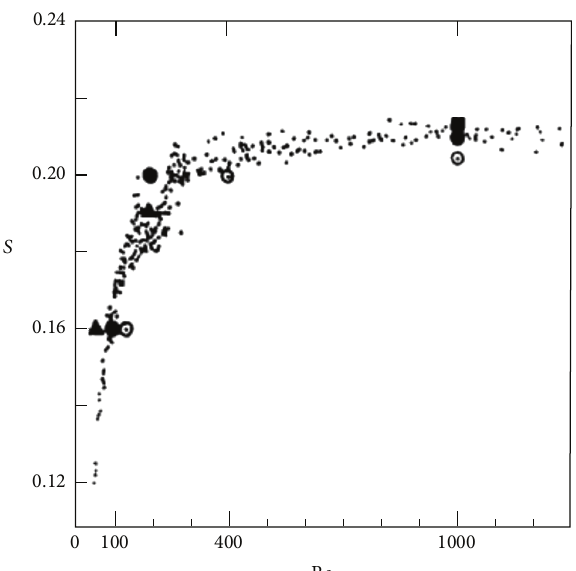
Figure 11: The Strouhal number versus Reynolds number [13].